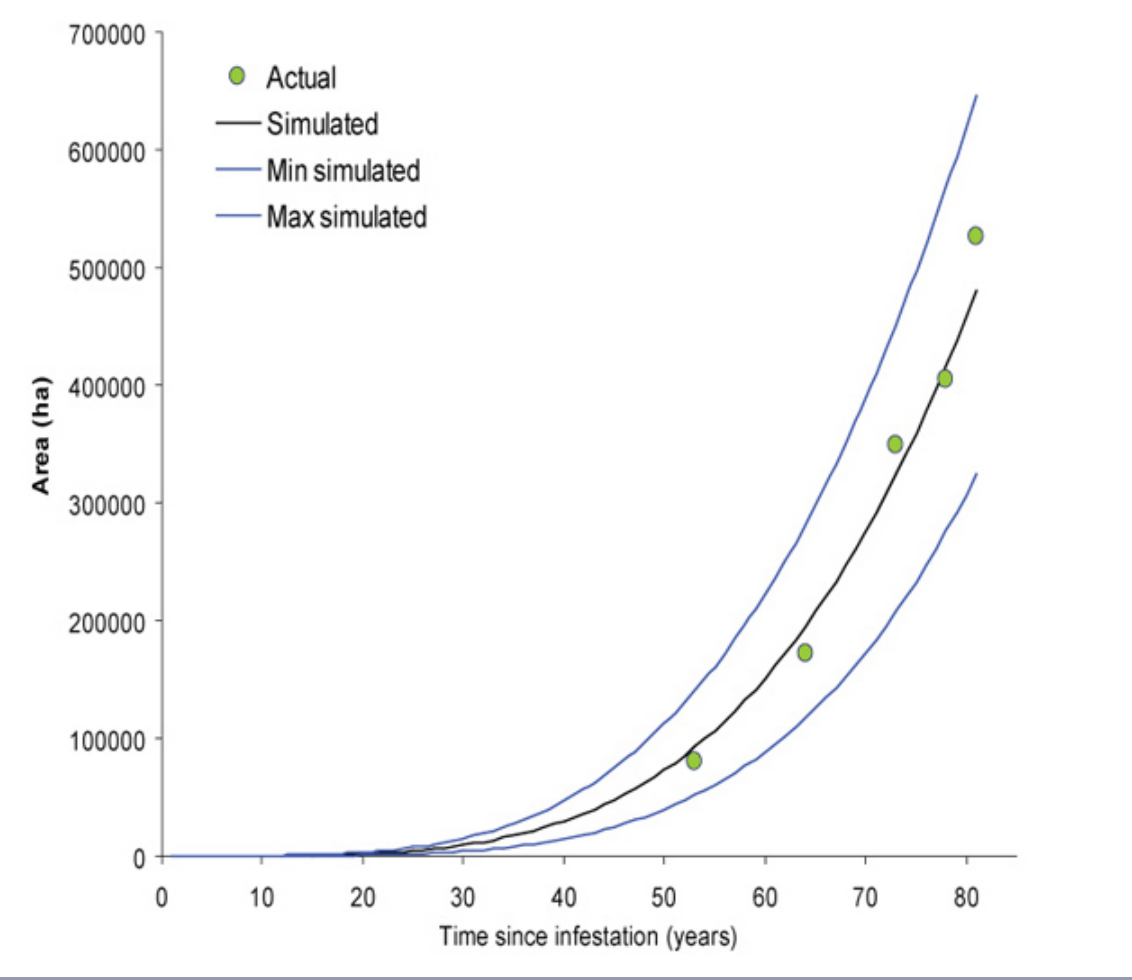
Fig. 1. Actual and simulated spread of leafy spurge in North Dakota rangeland over 81 yr. The simulated data are based on the mean of 100 simulations from the coupled map lattice model. The actual data are based on field measurements (see Table